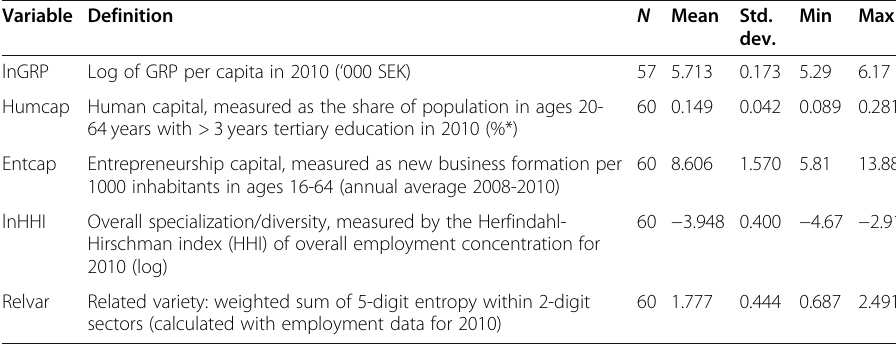
Table 3 Independent variables Variable